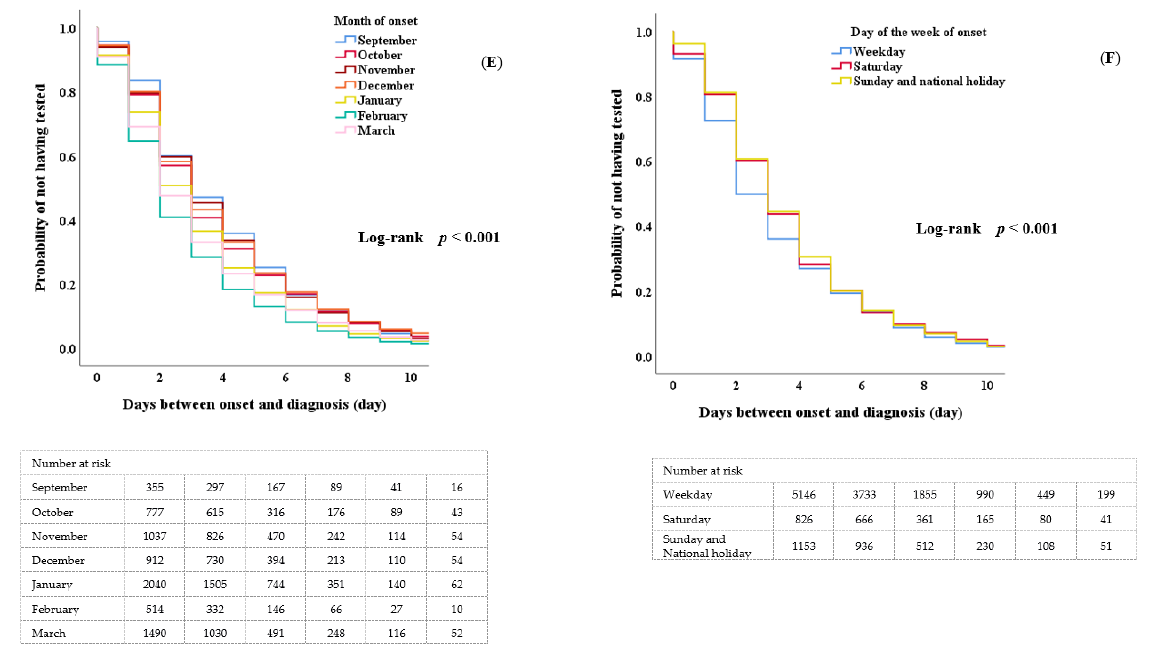
Commented [M10]: Figure 1A, Over 90 → 90 or over Please replace fig 1 with this new version.